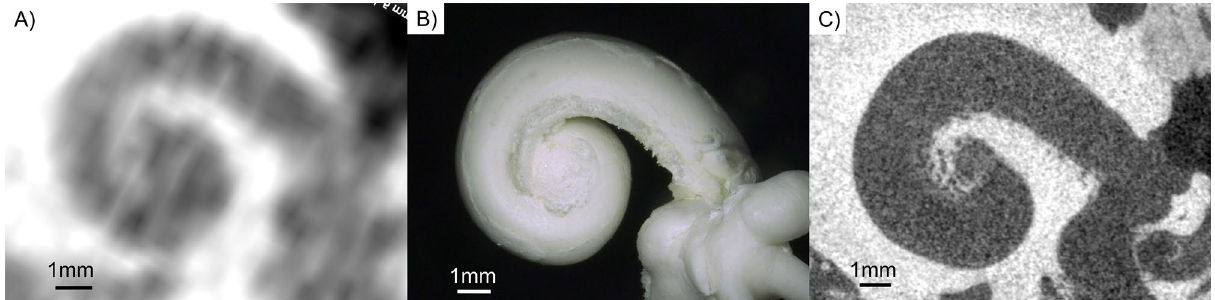
Figure 1. Imaging of the cochlea using the three methods used in the present study: ( A ) Cone beam computer tomography (CBCT); ( B ) Corrosion Cast; ( C ) micro computer tomography (µCT). The different methods differ in resolution and details, with corrosion casts and µCTs providing better resolution than